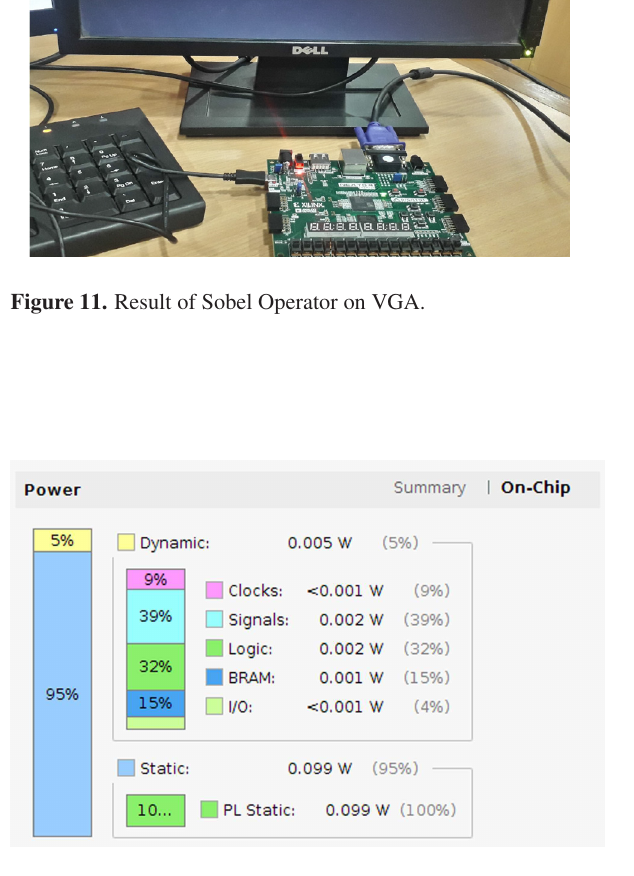
Figure 8. MATLAB result of Prewitt Operator.